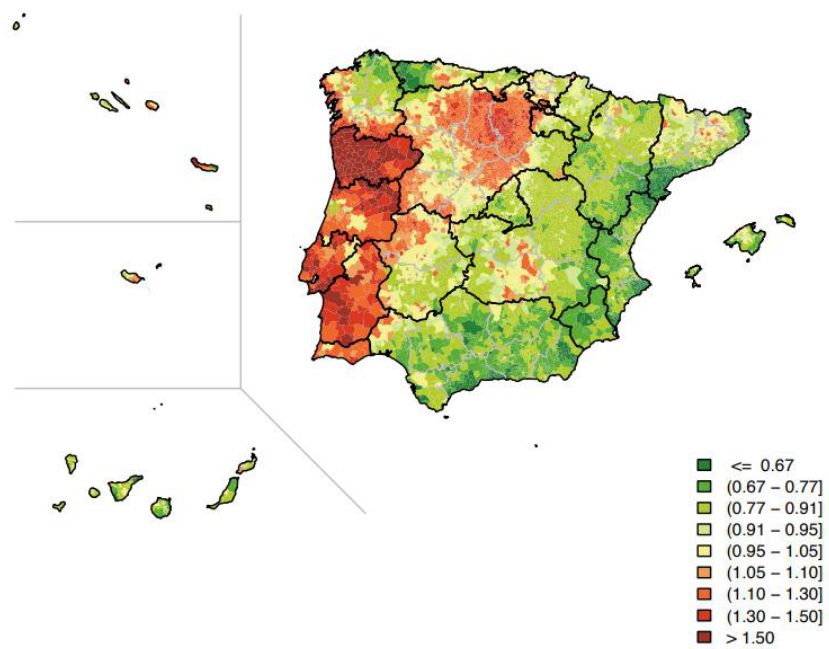
Figure 1. Relative risk of stomach cancer mortality in Portugal and Spain. Adapted from Ref. [8], 2021, Instituto de Salud Carlos III.